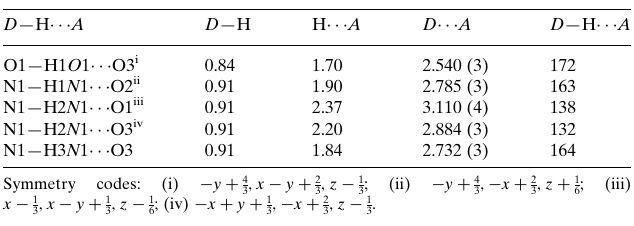
Hydrogen-bond geometry (A˚ , (cid:5)